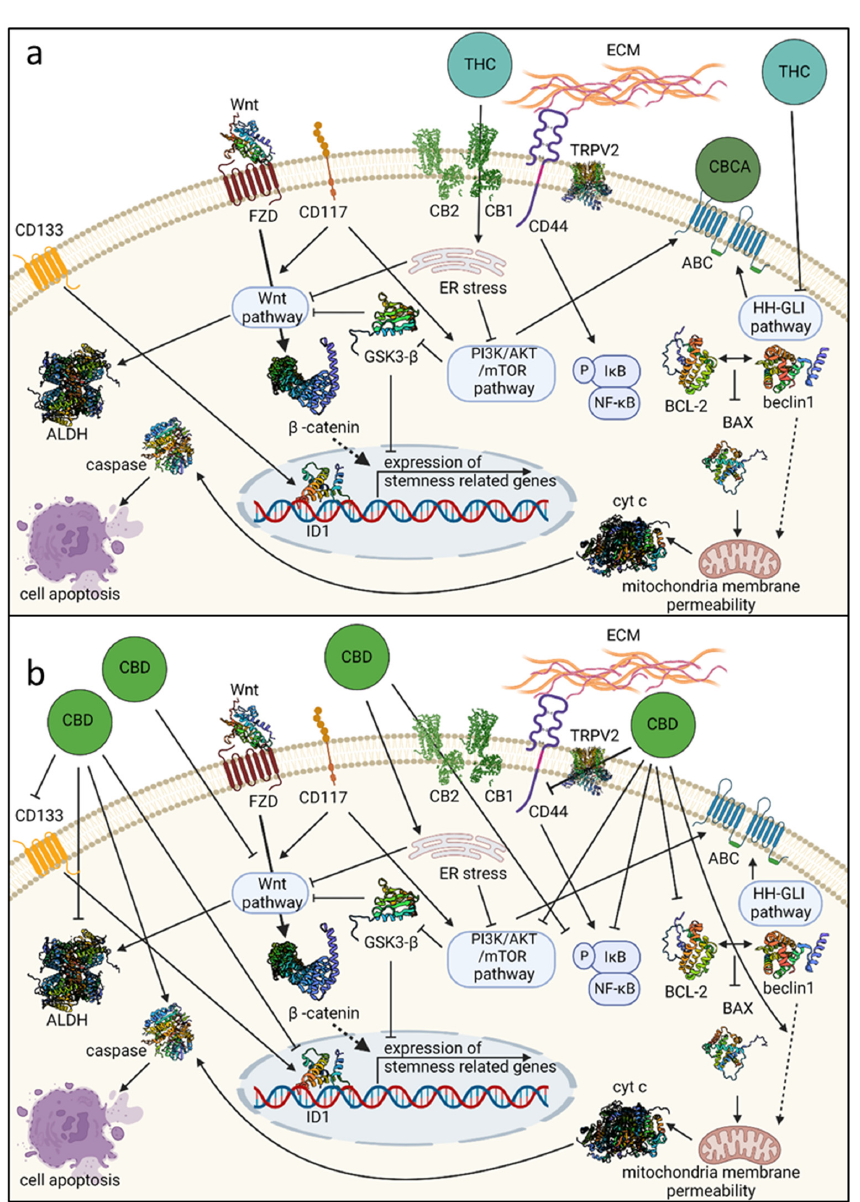
Figure 1. Some of the genetic pathways and mechanisms affected by phytocannabinoids: THC and CBCA ( a ) and CBD ( b ) that are associated with ovarian cancer stem cell state. Receptors are illustrated in cases where receptor involvement in activity was suggested. ABC, ATP-binding cassette transporter; ALDH, aldehyde dehydrogenase; BCL-2, the activity of B-cell lymphoma-2; CB1, cannabinoid receptor type 1; CB2, cannabinoid receptor type 2; CBCA, cannabichromenic acid; CBD, cannabidiol; CD, clusters of differentiation; cyt c, cytochrome c; ECM, extracellular matrix; ER stress, endoplasmic reticulum stress; FZD, Wnt frizzled receptor; HH-GLI, Hedgehog-GLI; ID1, an inhibitor of DNA binding; THC, ∆ 9 -trans-tetrahydrocannabinol; TRPV2, transient receptor potential cation channel subfamily V member 2. Created with BioRender.com (accessed on 29 August